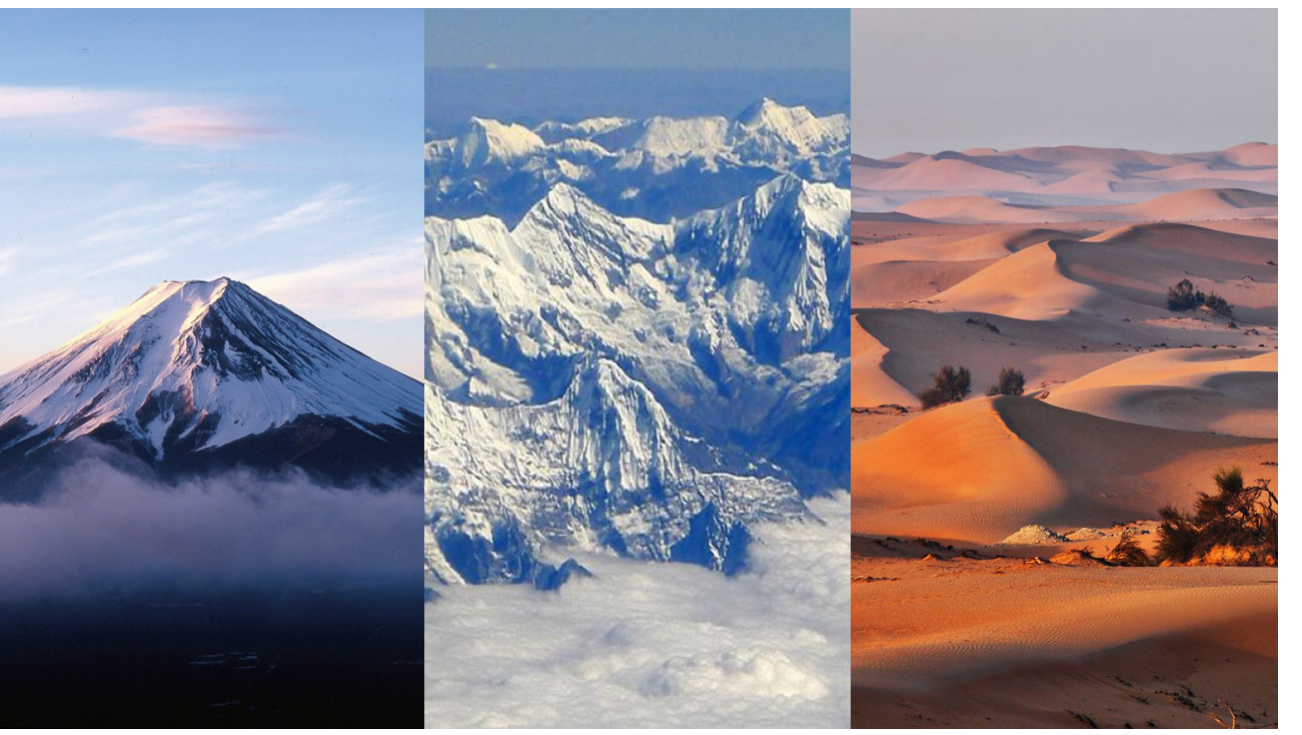
Figure 1. Three Landscape Types as Introduced in Page’s Metaphor.